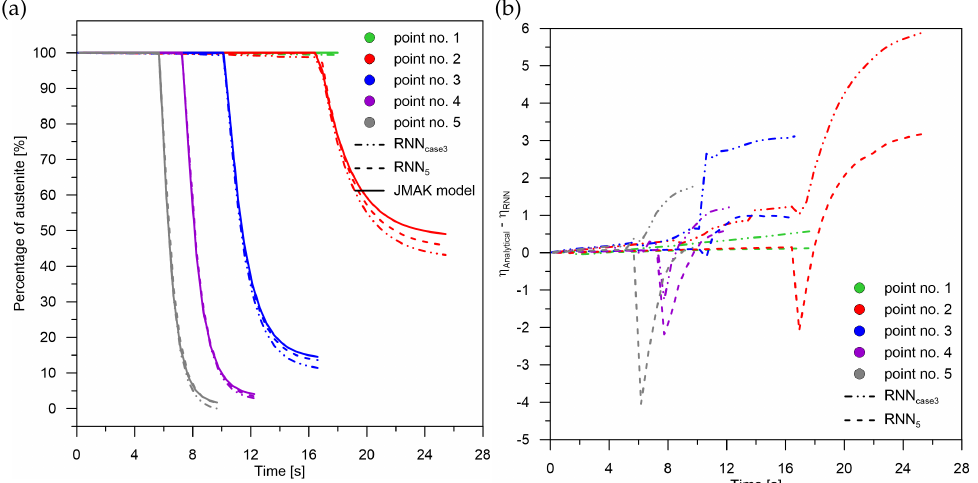
Figure 7. Phase transformation kinetics—case No. 3. ( a ) Phase transformation RNN 5 . ( b ) The difference between JMAK and RNN